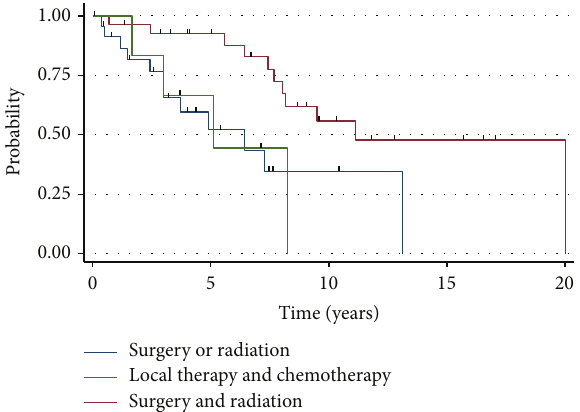
Figure 2: Progression-free survival for adults with L1 stage neuroblastoma. 𝑃 = 0.07